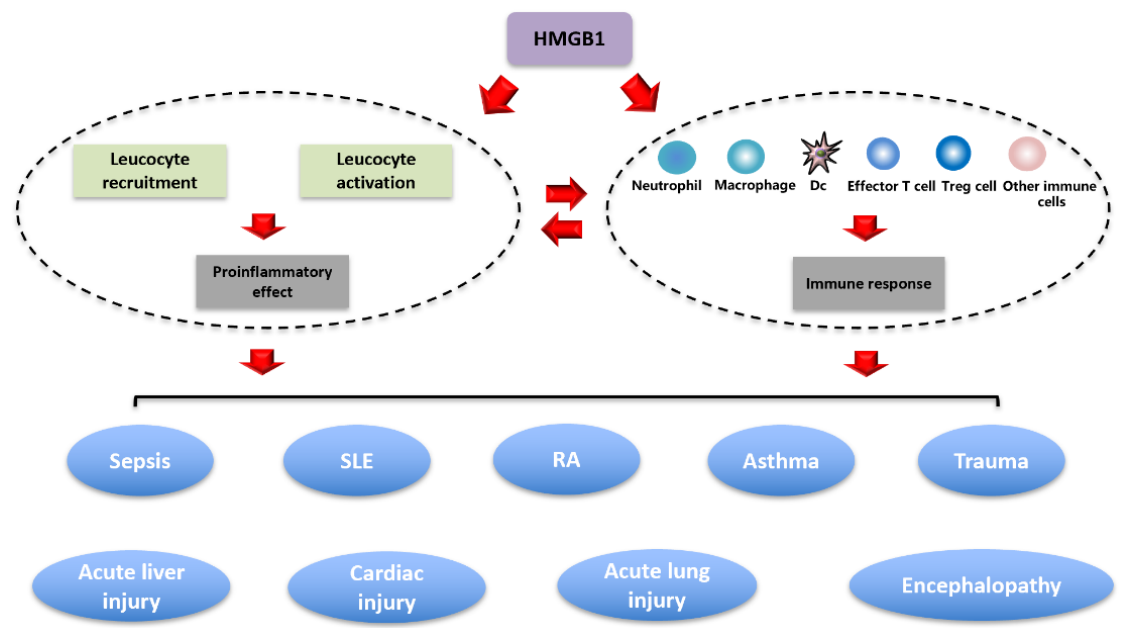
Figure 4. Roles of HMGB1 in various inflammatory disorders. The studies discussed in this review show that increased levels of extracellular HMGB1, whether in serum or tissue, can signal as a DAMP molecule to regulate inflammatory and immune responses, contributing to various inflammatory disorders, such as sepsis, SLE, RA, asthma, trauma, acute liver injury, cardiac injury, acute lung injury and encephalopathy. Abbreviations: HMGB1, high-mobility group box 1; Treg cell, regulatory T cell; DC, dendritic cell; DAMP, damage-associated molecular pattern; RA, rheumatoid arthritis; SLE, systemic lupus erythematosus. Abbreviations: HMGB1, high-mobility group box 1; RAGE, receptor for advanced glycation end products; TLR, Toll-like receptor; IL, interleukin; Th, T helper; NF- κ B, nuclear factor- κ B; LPS, lipopolysaccharide; SIRT1, sirtuin 1; TNF-α, tumor necrosis factor α; CLP, cecal ligation and puncture; RA, rheumatoid arthritis; SLE, systemic lupus erythema.